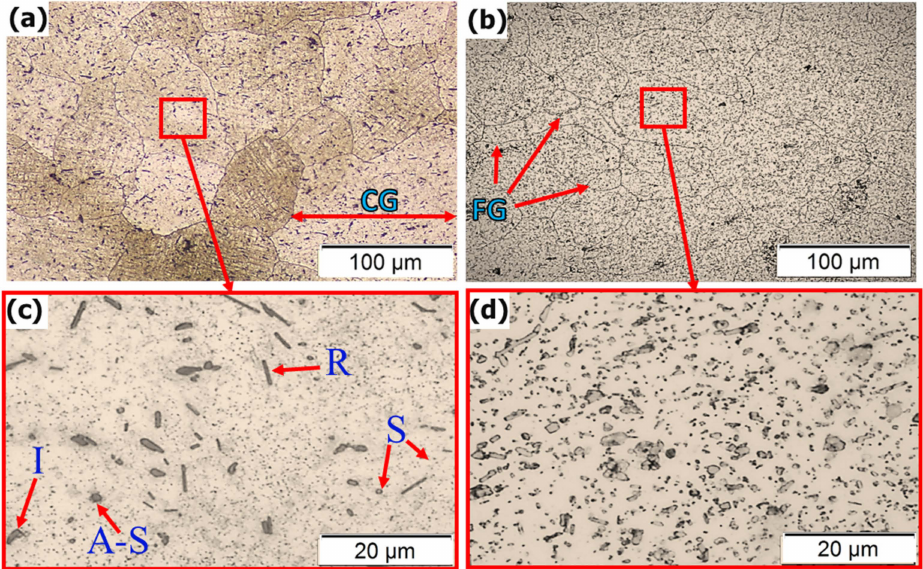
Figure 5. Low and high-magnification optical micrographs of the different temper conditions base material: ( a , c ) AA2011-T6 and ( b , d )